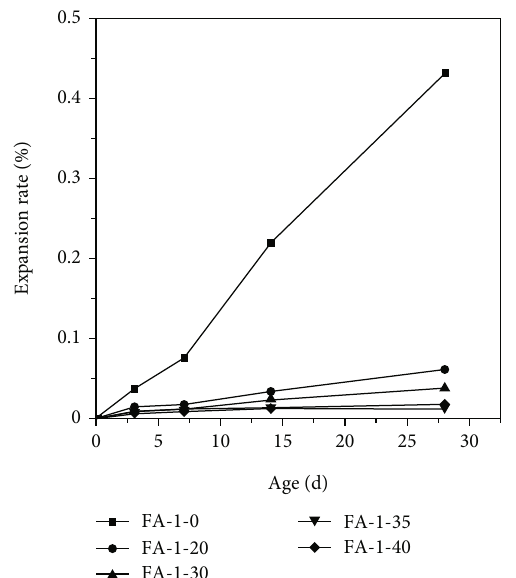
Figure 9: Graph of the expansion rate of the specimen and the amount of coal ash content (cement alkali content 0.60%).